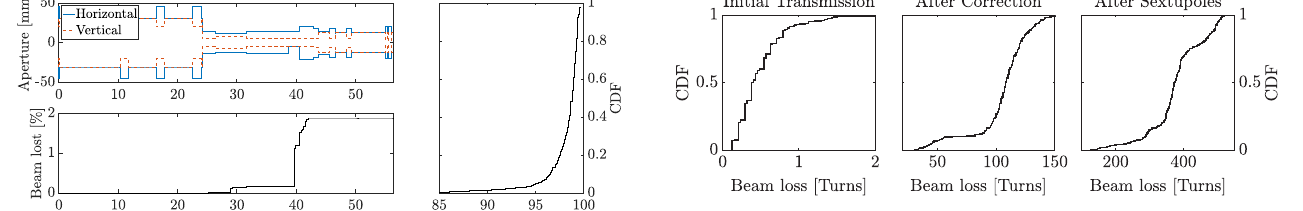
FIG. 12. Cumulative distribution function of the beam lost point in the AR for the baseline error assumption before any correction is applied (left), after trajectory correction (center) and after the sextupoles are switched on